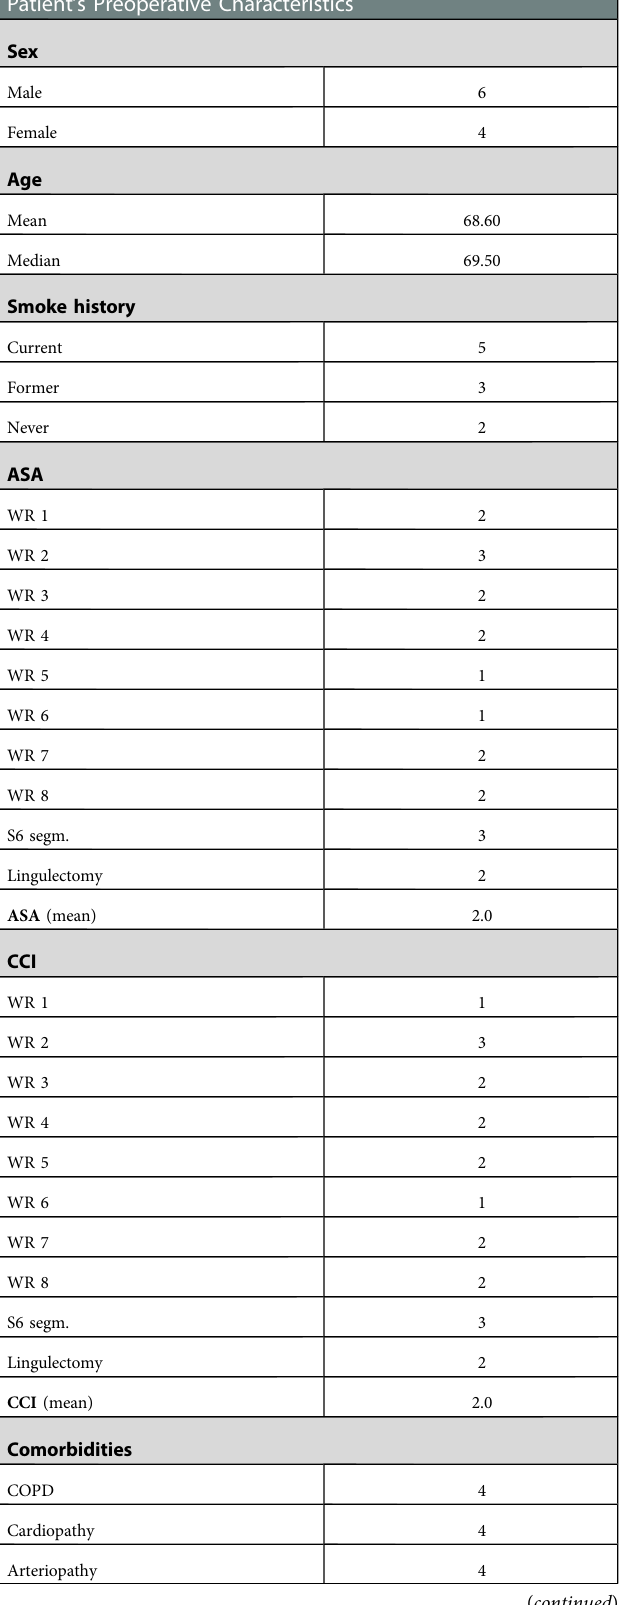
TABLE 1 Patients ’ preoperative characteristics. ASA: American Society of Anesthesiologists Classi fi cation; CCI: Charlson Comorbidity Index; COPD: Chronic Obstructive Pulmonary Disease; DM: Diabetes Mellitus; FEV1: Forced Expiratory Volume in 1 s; FVC: Forced Vital Capacity; DLCO: Diffusing Capacity for Carbon Monoxide; WR: Wedge Resection.